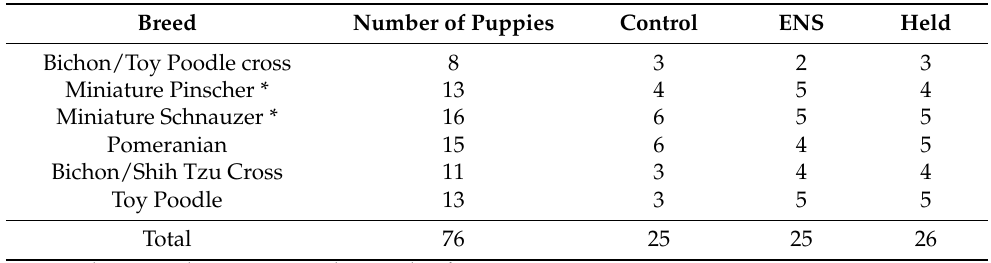
Table 1. Breeds represented in the sample, number of puppies per breed, and number of puppies per treatment group within each breed. Breed Number of Puppies Control ENS Held Bichon/Toy Poodle cross 8 3 2 3 Miniature Pinscher * 13 4 5 4 Miniature Schnauzer * 16 6 5 5 Pomeranian 15 6 4 5 Bichon/Shih Tzu Cross 11 3 4 4 Toy Poodle 13 3 5 5 Total 76 25 25